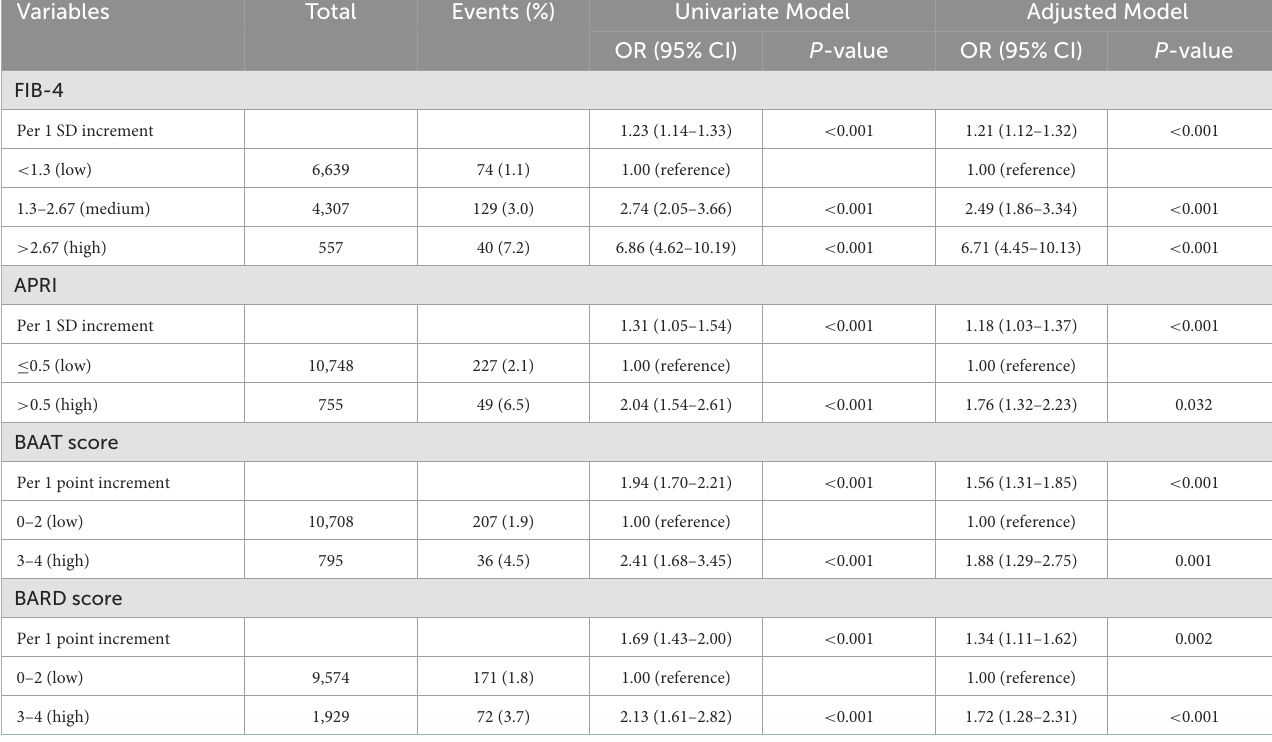
TABLE 2 Univariate and multivariate logistic regression of LFSs for CKD.